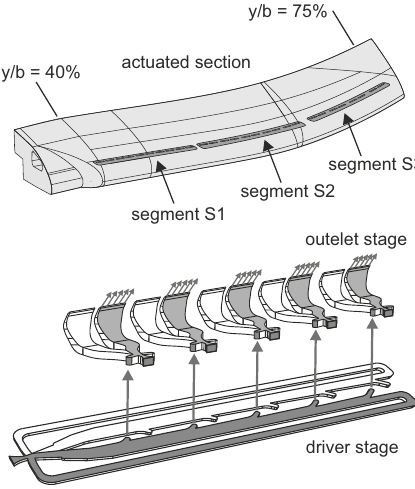
Figure 2. Sketch of the active flow control (AFC)